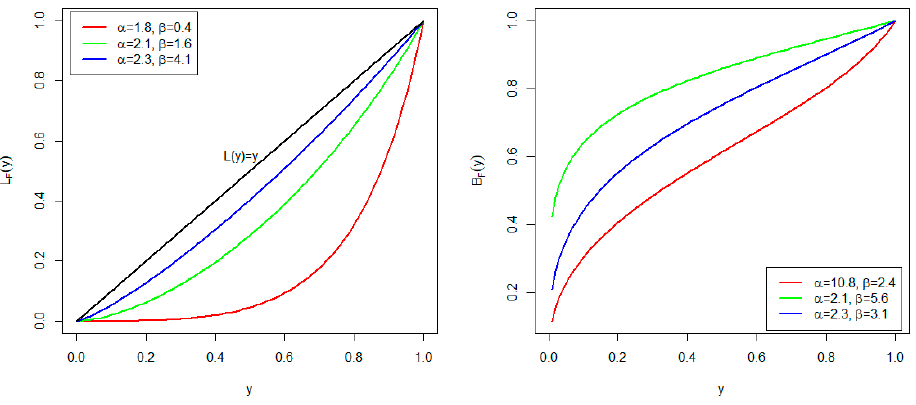
Figure 3. Plots of Lorenz curve ( left ) and Bonferroni curve ( right ). When non-central moments of a random variable exist, they can be found using the moment-generating function (MGF).